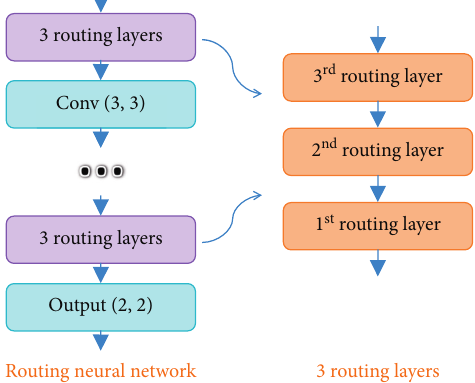
Figure 8: Network architectures of the routing neural network and 3 routing